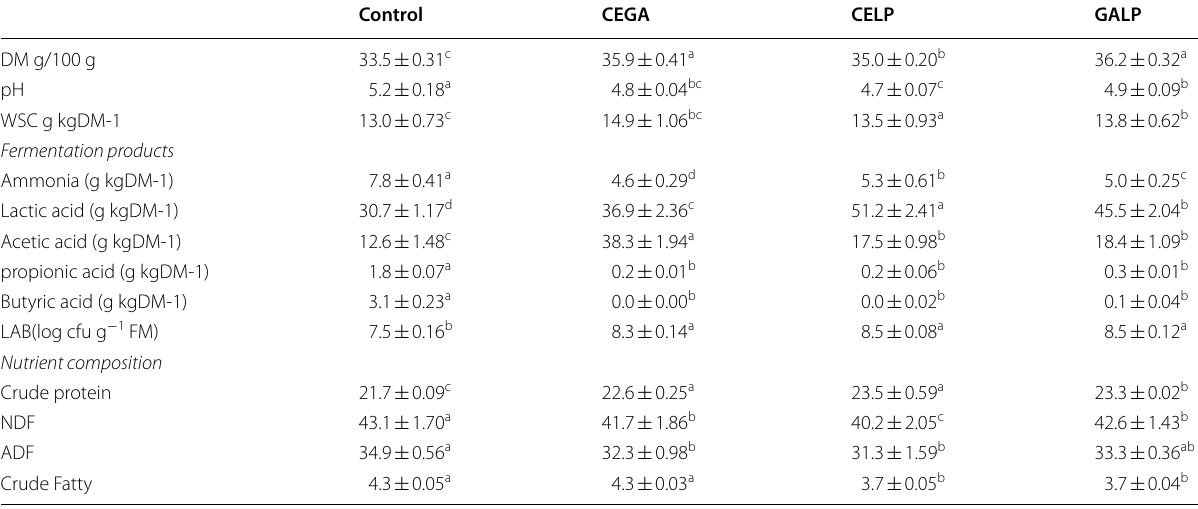
CON untreated silage, CEGA silage treated with cellulase plus ɑ -galactosidase, CELP silage treated with cellulase plus L. plantarum , GALP silage treated with ɑ -galactosidase plus L. plantarum a, b, c Means with different superscripts in the same row differ ( P < 0.05)